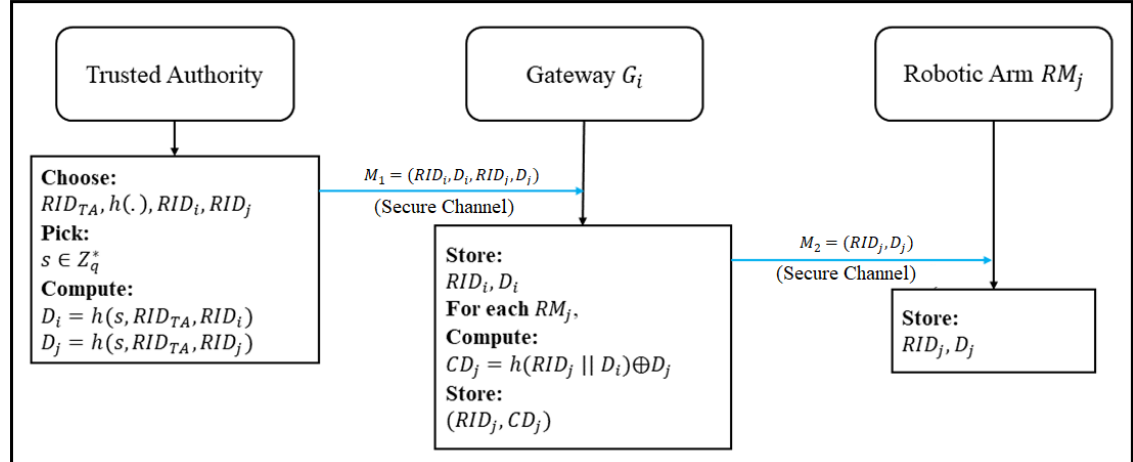
Figure 3. Registration process of gateway and robotic arms of the enhanced scheme.